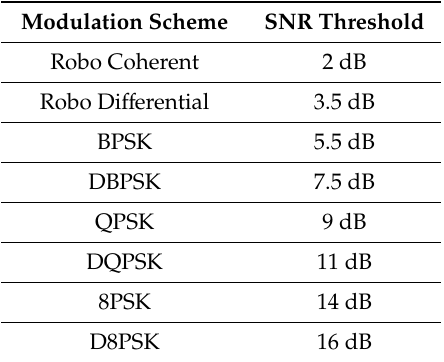
Table 1. SNR thresholds for tone map